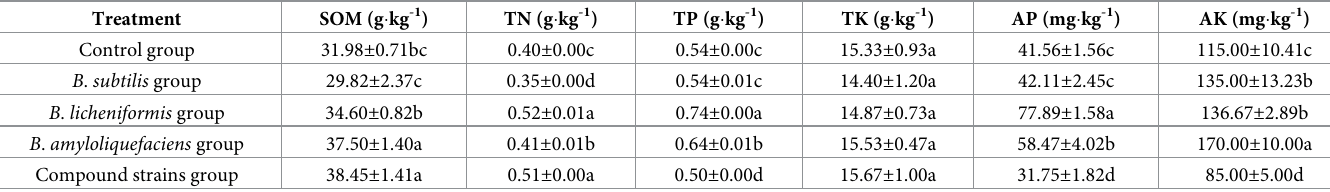
Table 1. Physical and chemical properties of the maize rhizome soil samples.